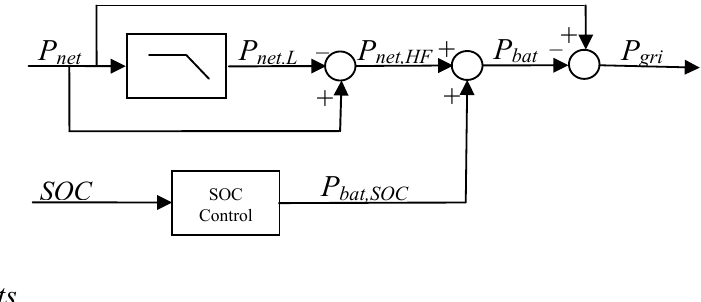
Figure 4. Block diagram of the low-pass filter based energy management strategy. SOC: state of charge.